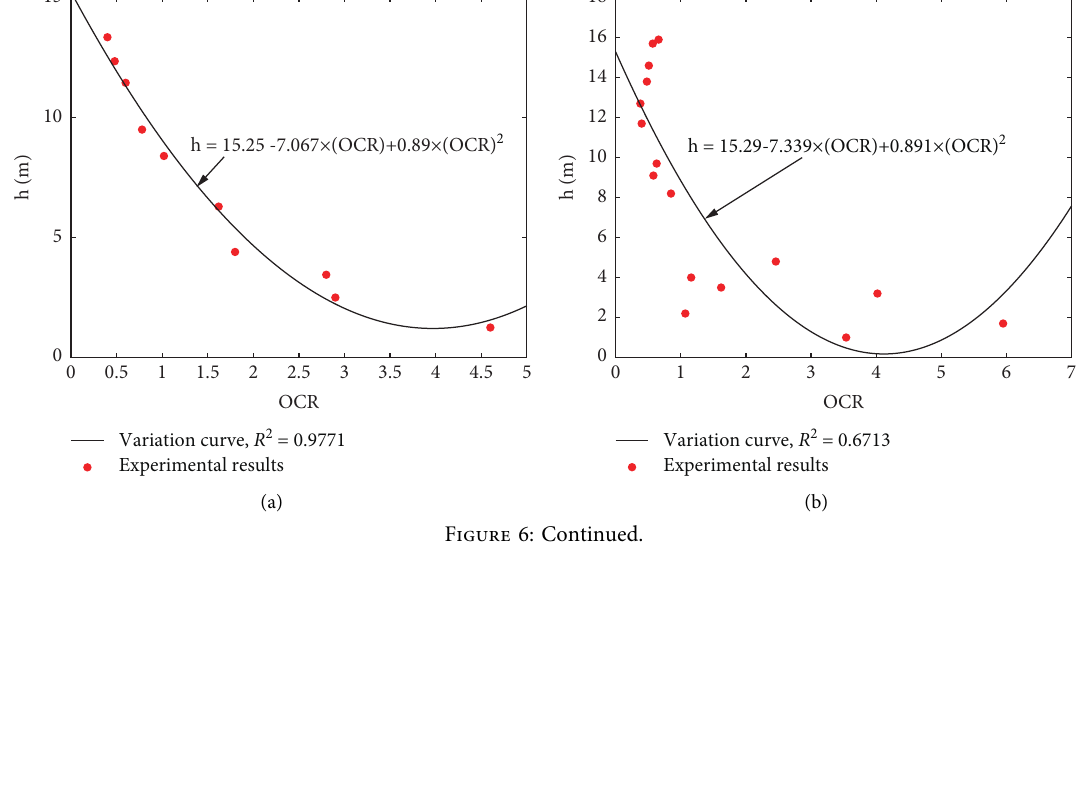
Variation curve, R 2 =